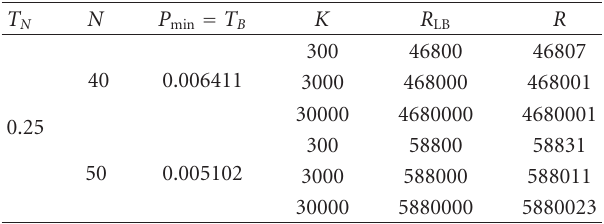
Table 1: Relative parameters in two